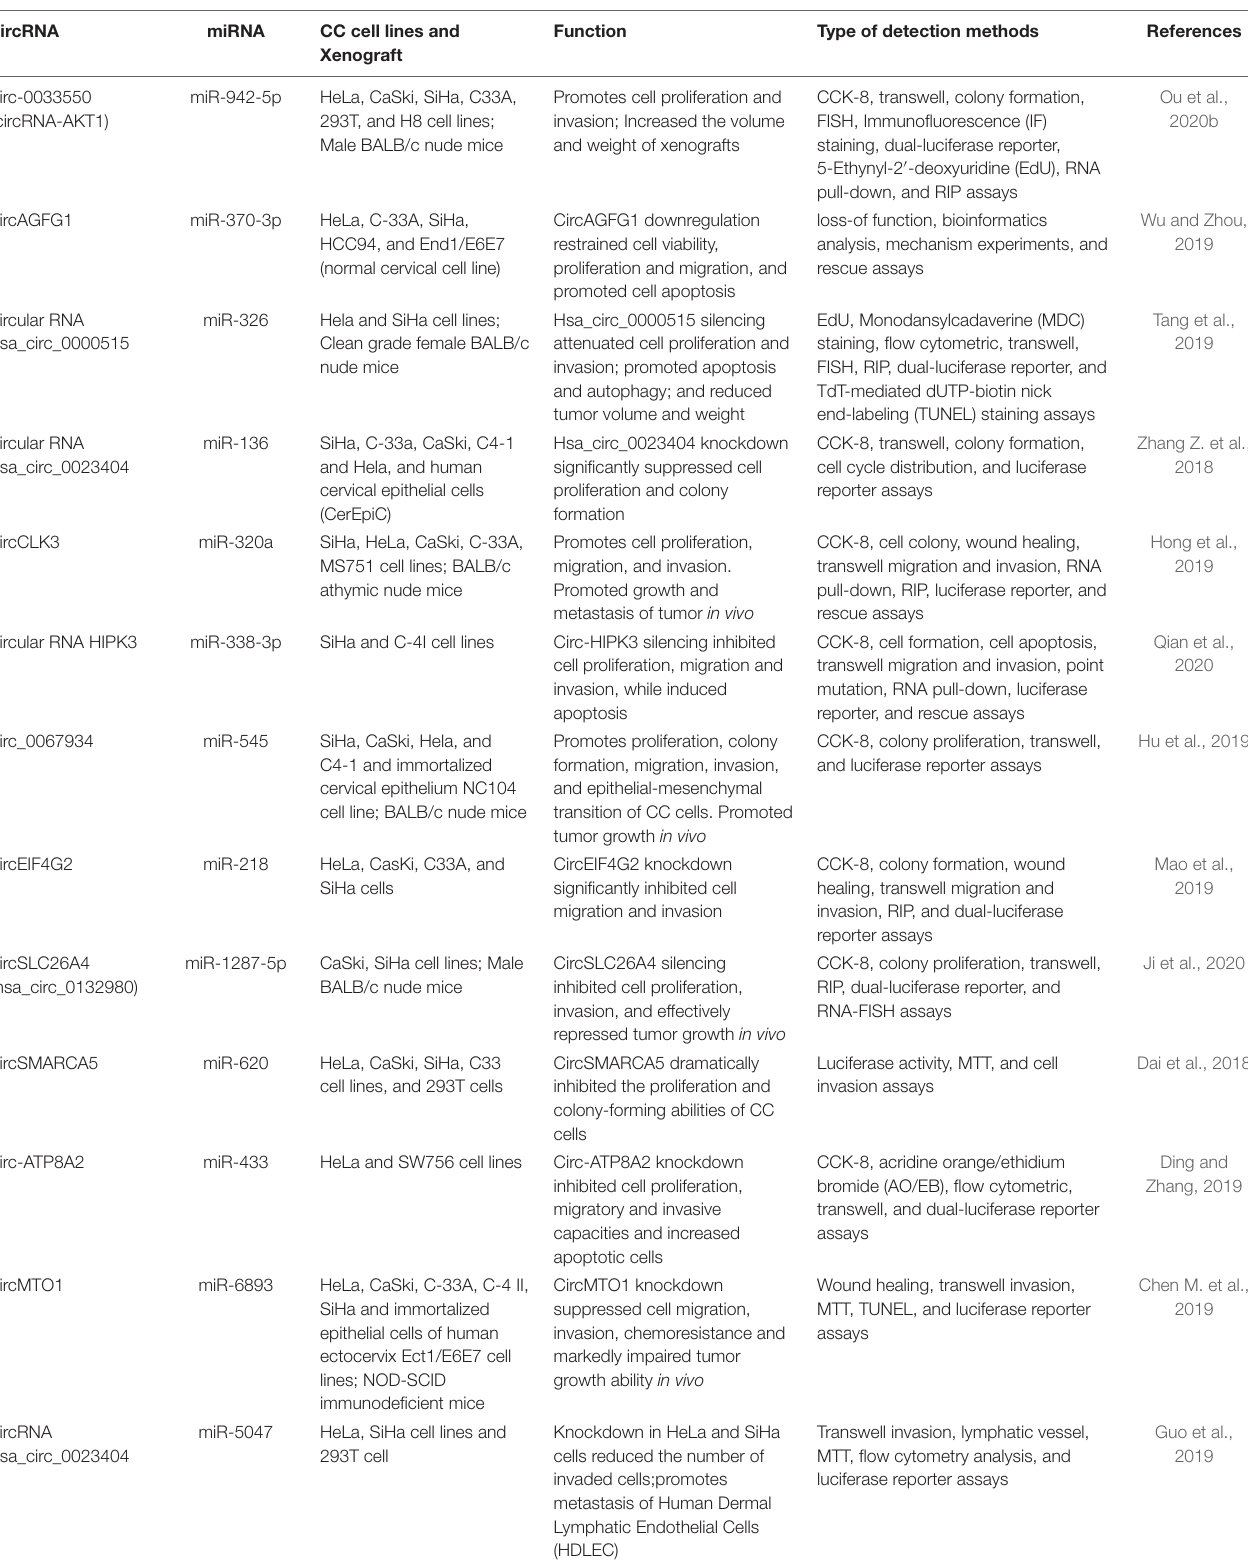
TABLE 1 | The effects of circRNA on CC cell